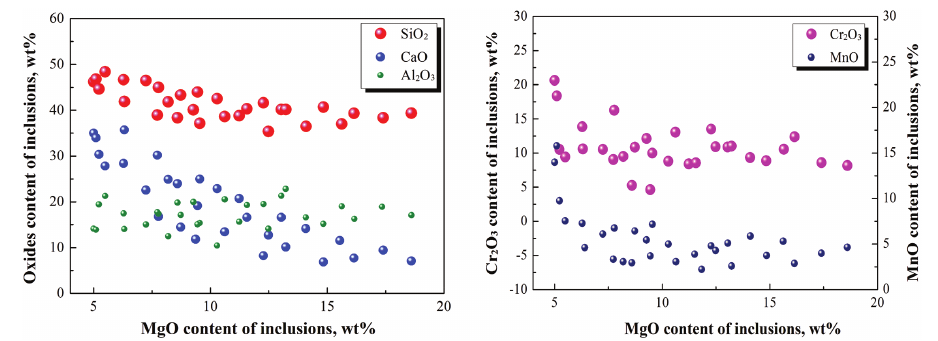
Figure 9: Inclusions composi- tion in region (1) as a function of the MgO content inclusions.